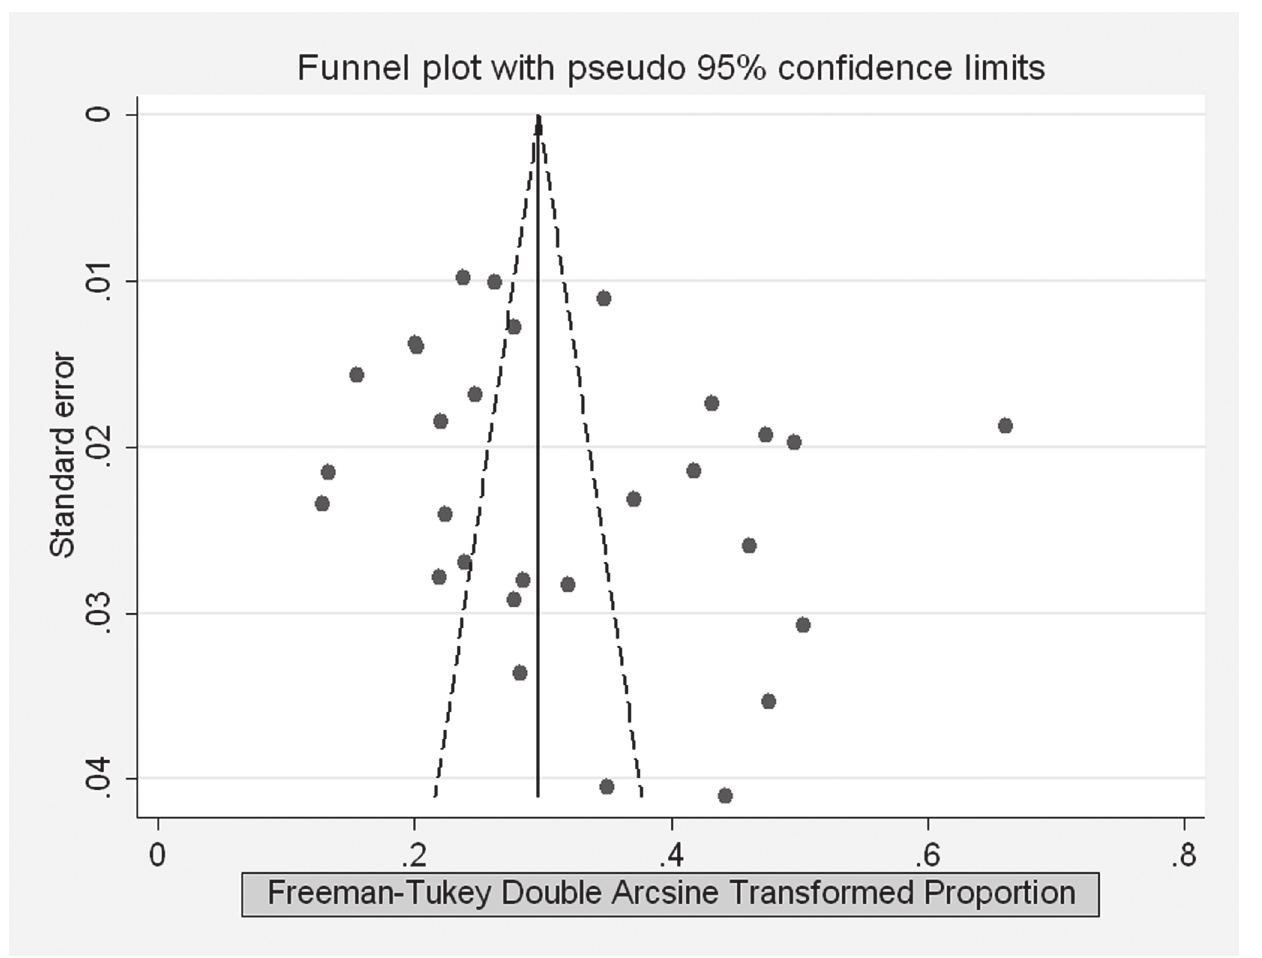
Figure 3. Funnel plot of the 29 studies included in the meta-analysis.